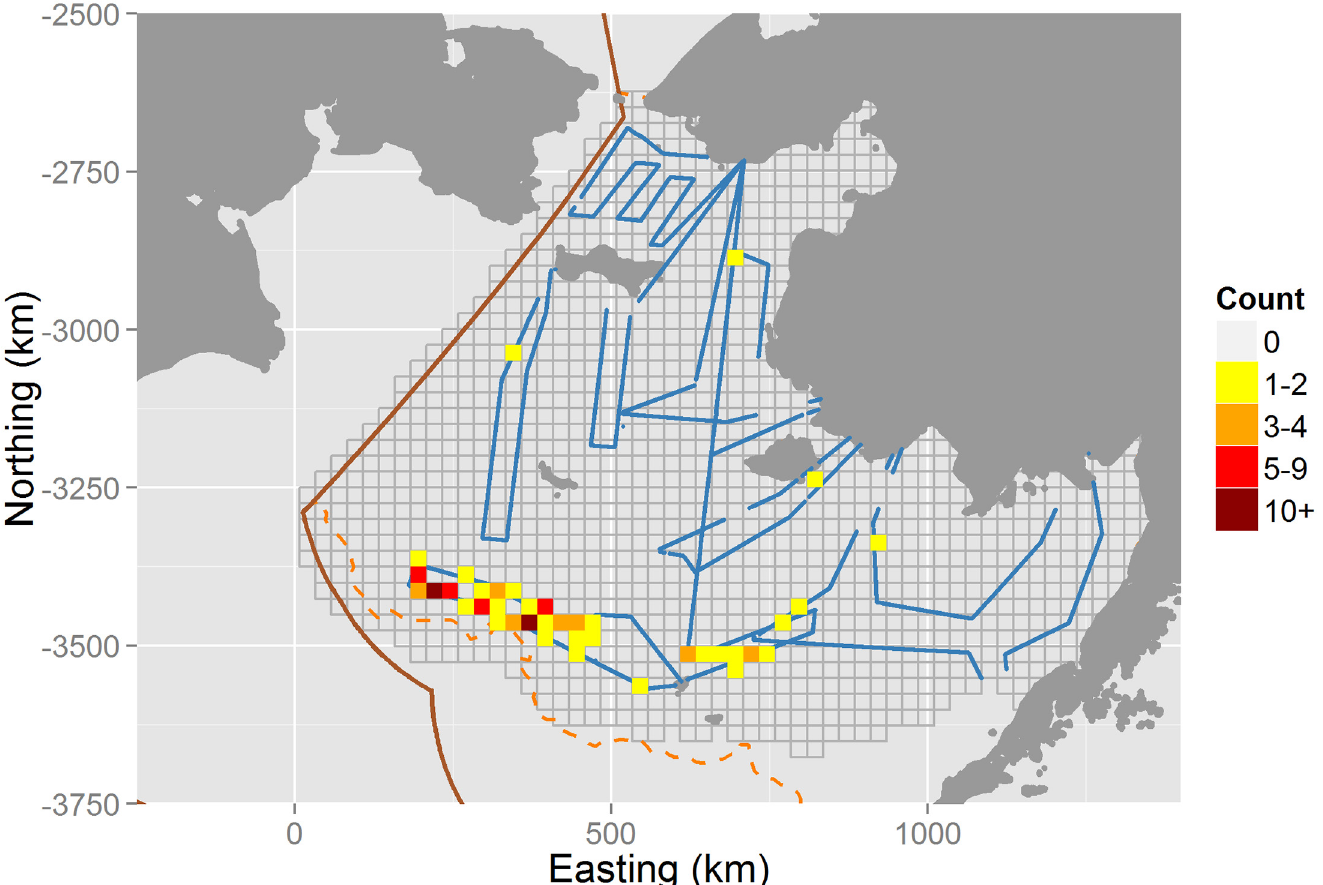
Fig 4. Aerial survey tracks over the Bering Sea, April 22 – 29, 2012. Survey tracks are shown in blue, and are overlayed on a tesselated study area consisting of 25km by 25km grid cells (gray lines). Dark gray indicates land, while the orange dashed line indicates a 1000m depth contour, and the solid brown line shows the U.S Exclusive Economic Zone (EEZ) boundary. Colored pixels indicate ribbon seal counts along aerial transects. The average effective area surveyed in each grid cell was approximately 2.6km 2 (0.4%). Note that surveys were designed to target multiple seal species, several of which had high densities further north (results not